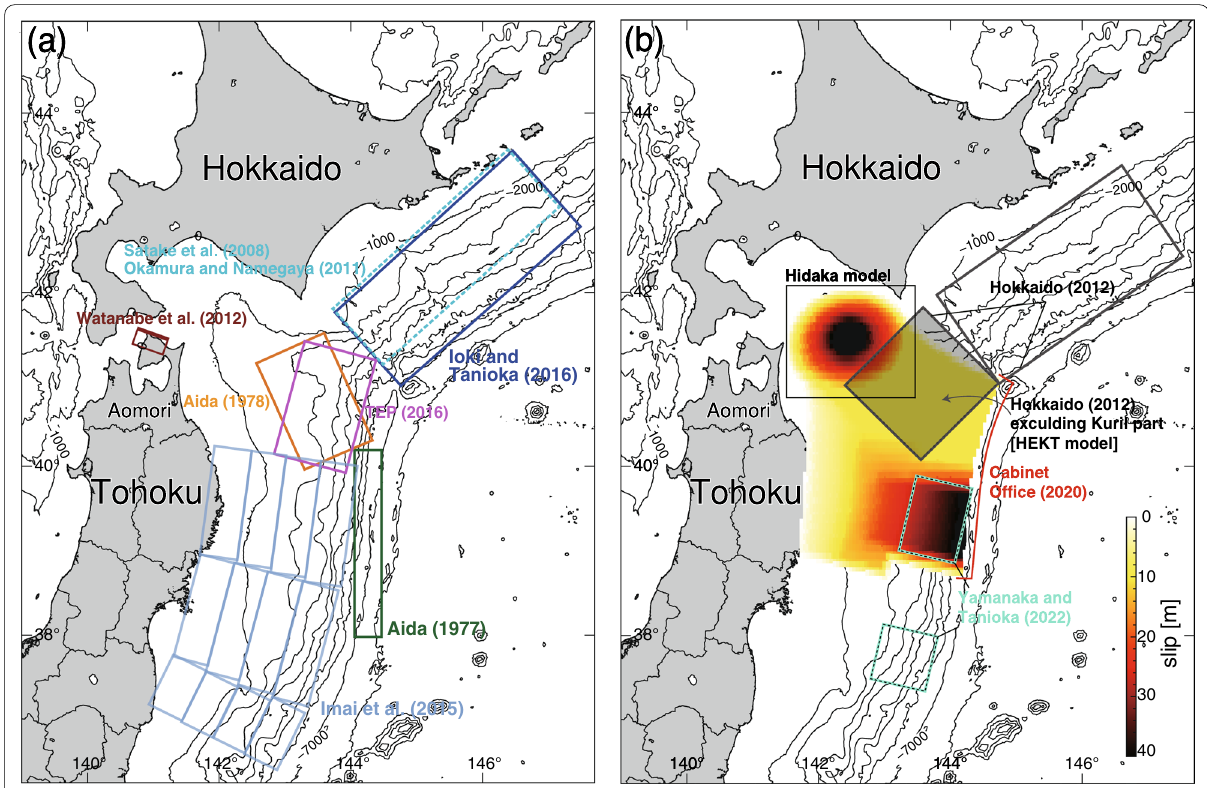
Fig. 3 Previously proposed fault models used in this study. a The eight fault models of the historical tsunami (Aida 1977, 1978; Satake et al. 2008; Okamura and Namegaya 2011; Watanabe et al. 2012; Imai et al. 2015; Ioki and Tanioka 2016; Tohoku Electronic Power 2016). b One historical tsunami model (Yamanaka and Tanioka 2022), two disaster prevention models (Hokkaido Disaster Prevention Council 2012; Cabinet Office 2020), and modified previously proposed models (i.e., HEKT and Hidaka models). The color bar in b shows the slip amount of the Cabinet Office (2020) model. See Table 2 for details. The gray lines are bathymetric contour lines drawn at 1000 m